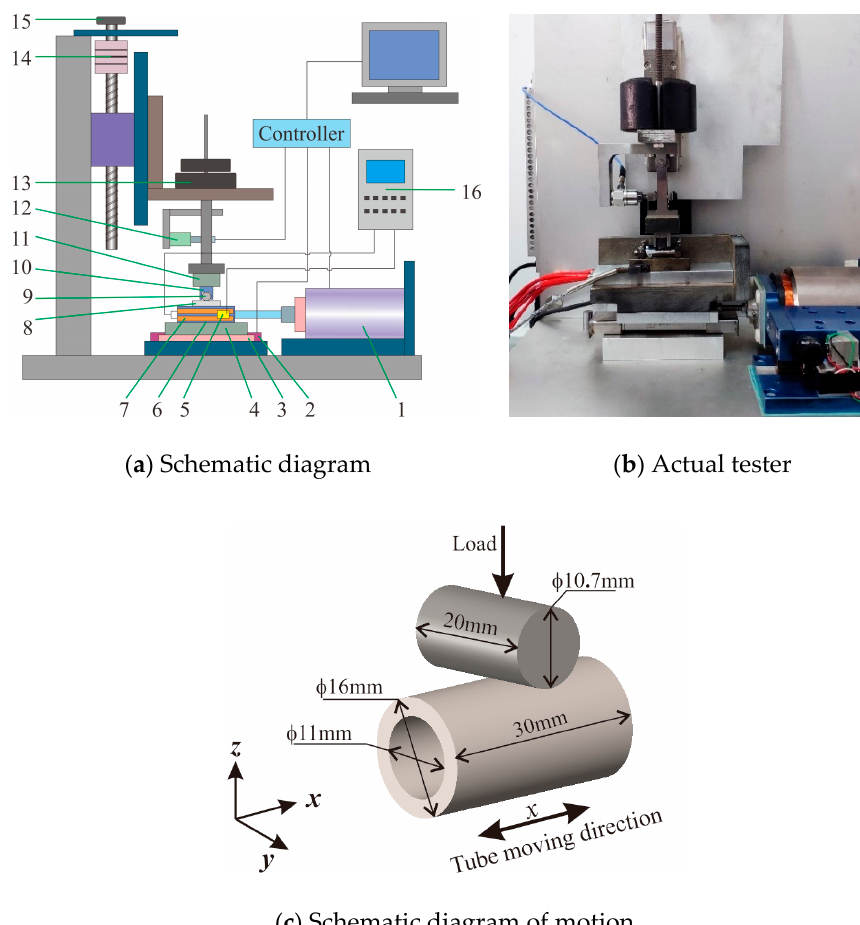
Figure 1. Test equipment ( a , b ): (1) voice coil motor; (2) grating ruler; (3) guide rail; (4), (11) heat insulation plate; (5) temperature sensor; (6) lower fixture; (7) heating rod; (8) lower sample; (9) upper sample; (10) upper fixture; (12) force sensor; (13) weights; (14) envelope; (15) spinner handle; (16) temperature control box, and schematic diagram of motion ( c ).